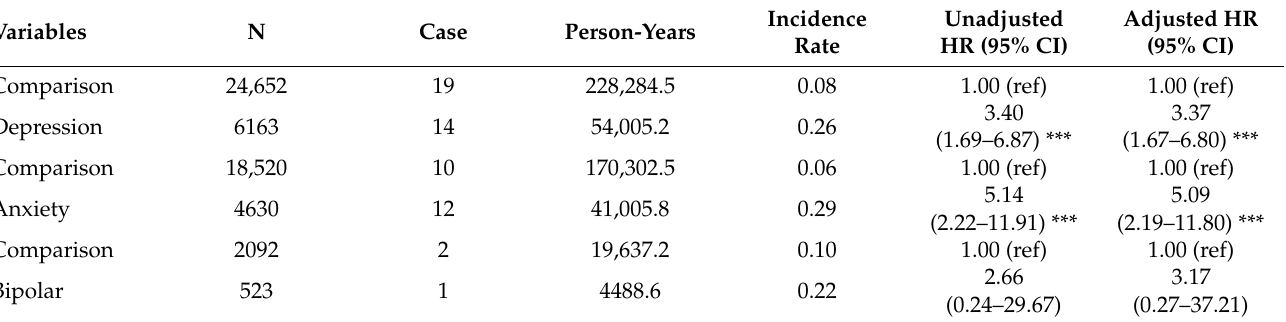
Table 5. The risk of incident burning mouth syndrome in patients with depression, anxiety, and bipolar compared to that in the comparison group.